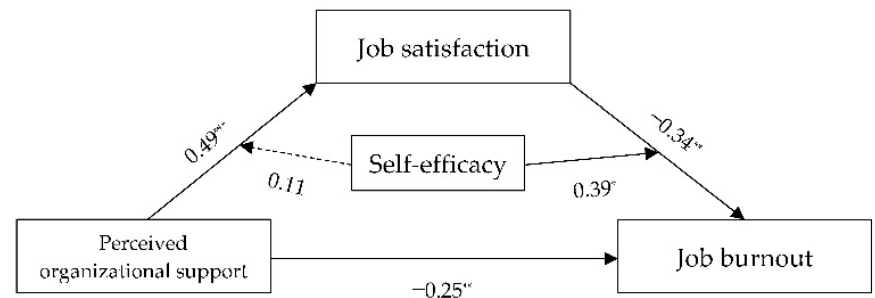
Figure 3. Moderated mediation test. * p < 0.05, ** p < 0.01, *** p < 0.001.